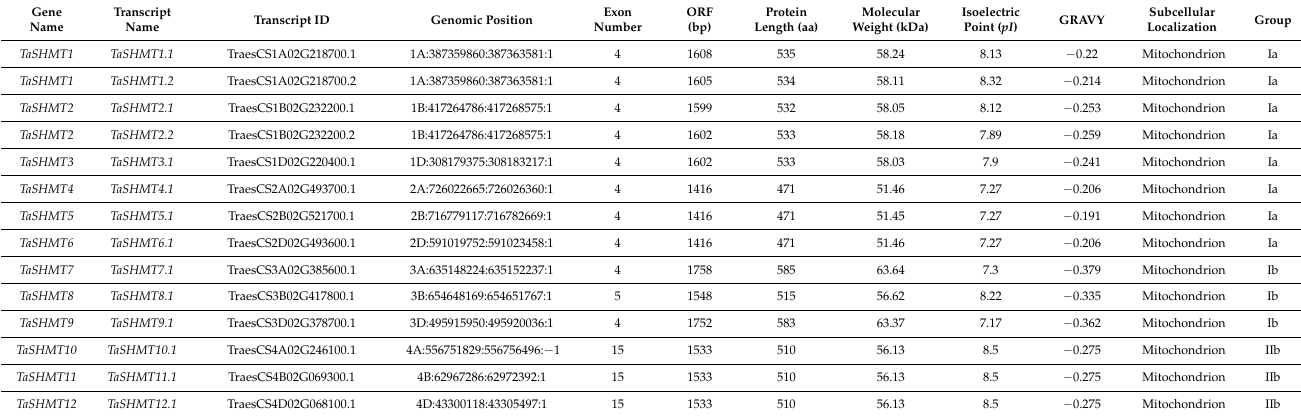
Table 1. The characteristics of SHMT genes in wheat.